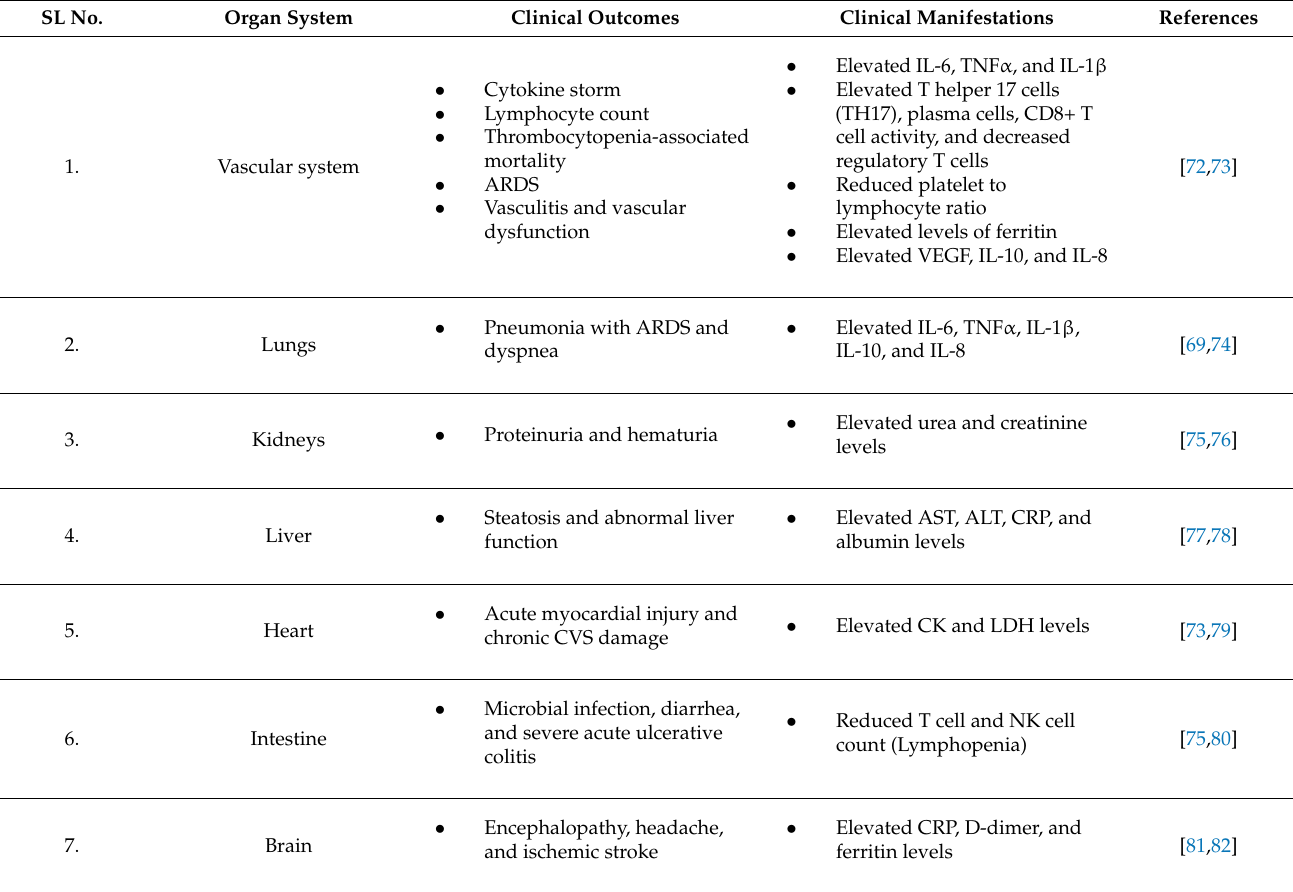
Table 2. SARS-CoV-2-induced immunopathology in humans: symptoms and clinical consequences. SL